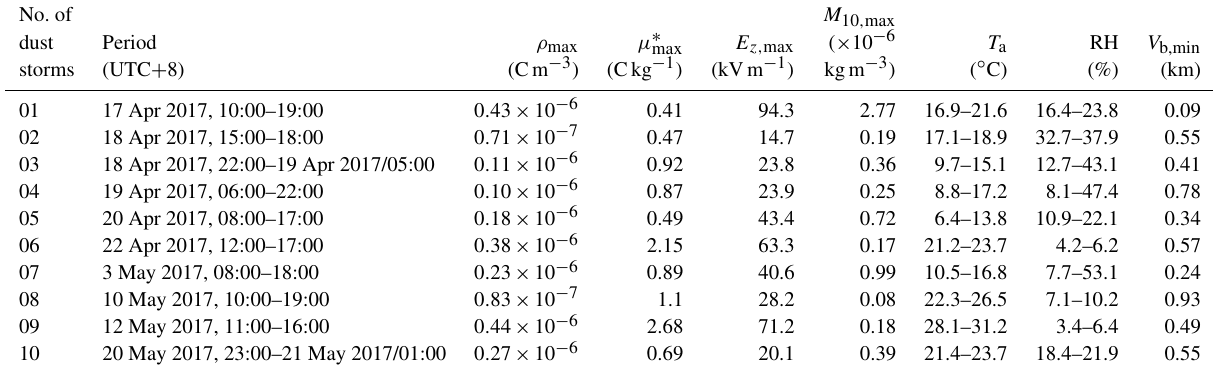
Table 1. Overview of the 10 dust storms observed. ρ max , µ ∗ max , E z, max and M 10 , max denote the maximum value of estimated space charge density, scaled charge-to-mass ratio, intensity of vertical E-field and PM 10 mass concentration during a dust storm; T a and RH denote the range of ambient temperature and relative humidity during a dust storm; V b , min denotes the minimum visibility during a dust storm. No. of M 10 , max dust